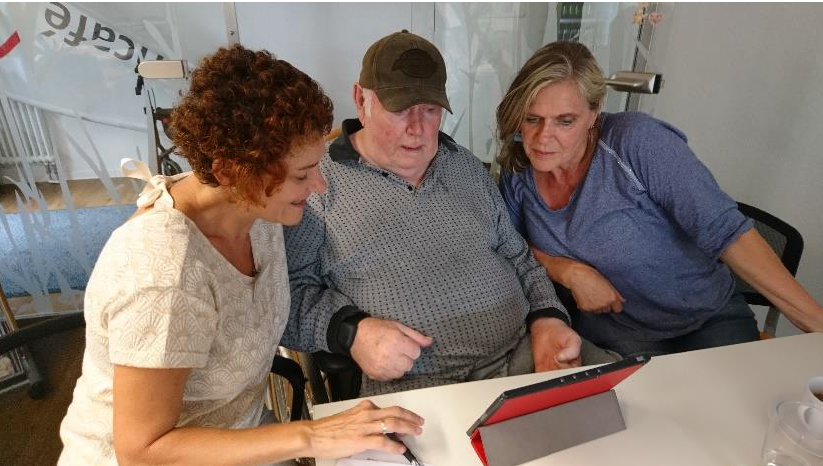
Figure 1. I-CARE tandem session session (Source: © AWO Karlsruhe gGmbH – a written informed consent was obtained from the individuals for the publication of this image).